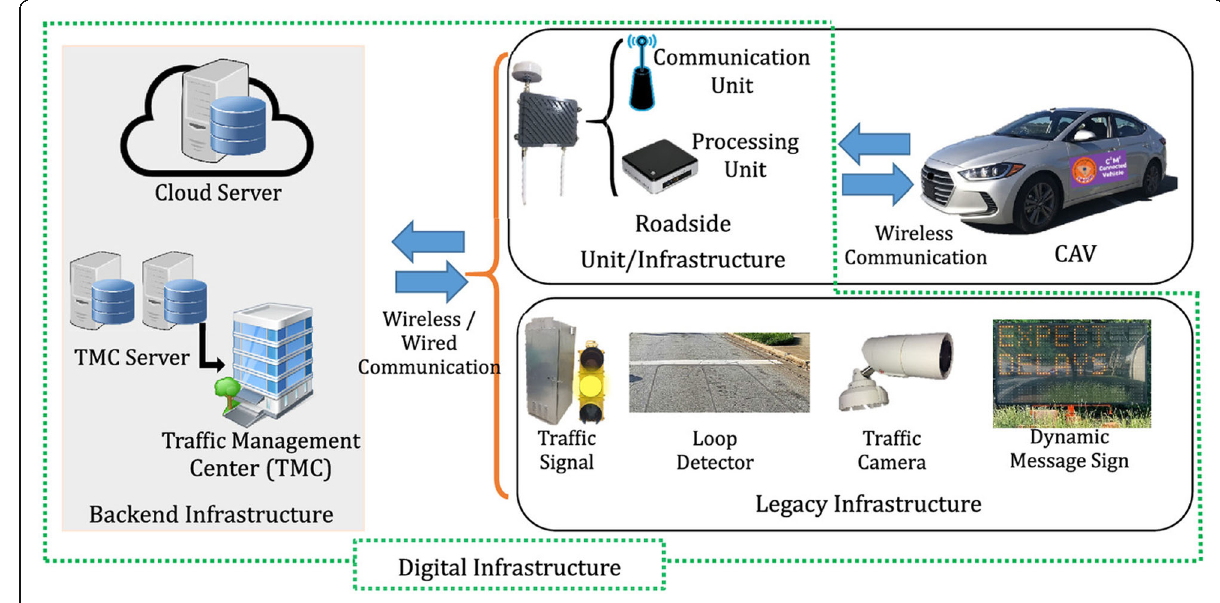
Fig. 2 Roadway digital infrastructure components (With permission of ASCE,